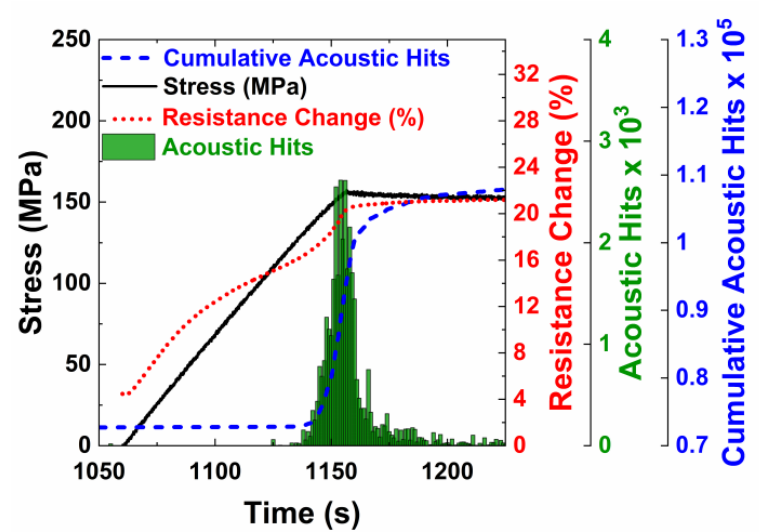
Figure 9. Stress, acoustic activity, and resistance change for the fifth loading cycle, where the non-linear electrical resistance response corresponds to crack re-opening, elastic loading, and new damage.